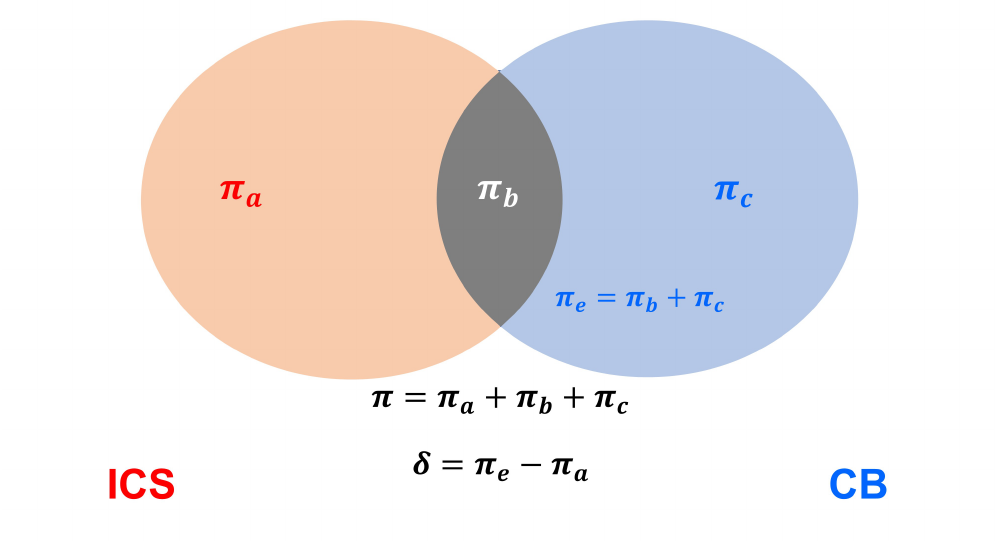
Figure 4. Venn diagram illustrating the incidence π of a specific NC in a producer group, its components π a , π b , π c and π e and the definition of δ . Refer to Table 2 for further details. ICS = Internal Control System, CB = Certification Body.